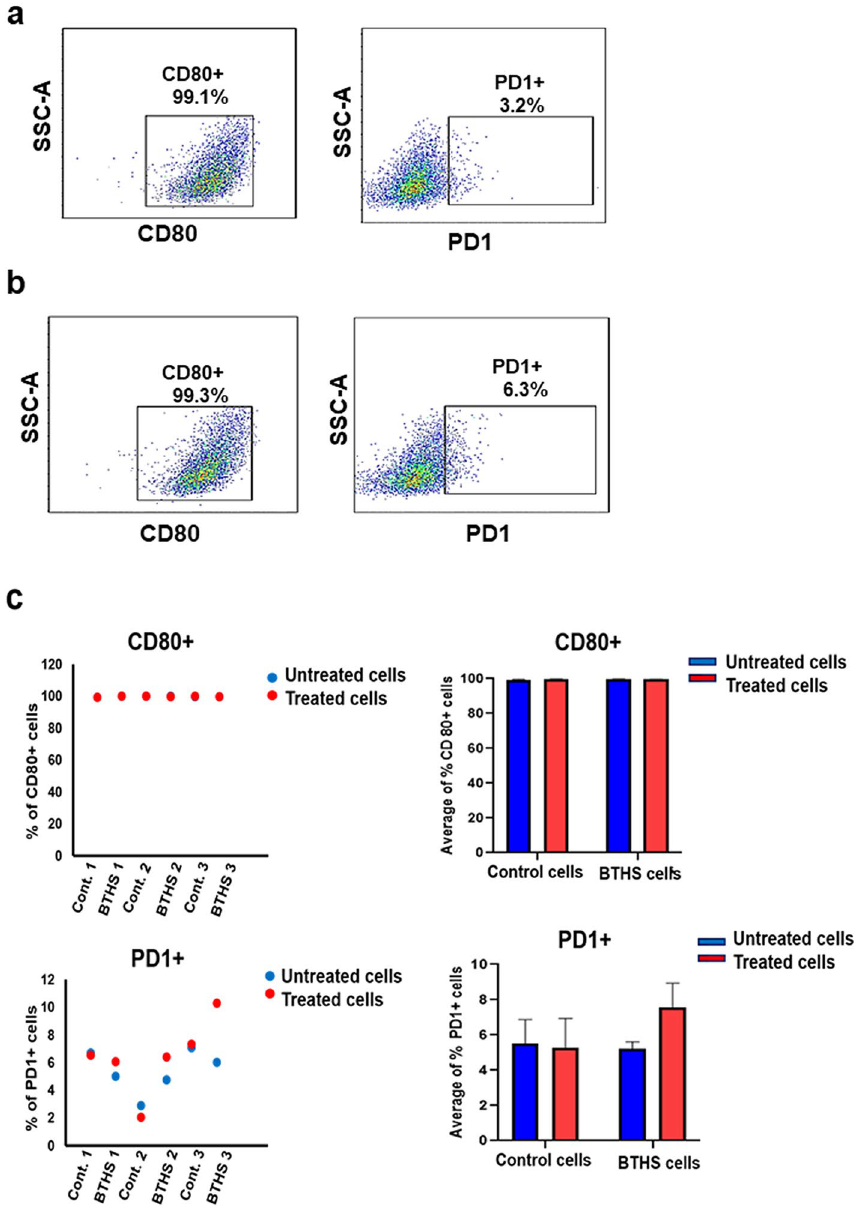
Figure 3. CD80 + and PD1 + surface markers expression in Epstein-Barr virus transformed human age- matched control and BTHS lymphoblasts after LPS stimulation. The expression of CD80 + and PD1 + surface markers were determined in control and BTHS lymphoblasts after stimulation without or with 10 µg/ml LPS using flow cytometry as described in “Materials and Methods”. ( a ) Representative flow cytometry images of CD80 + and PD1 + surface markers in control cells after LPS stimulation. ( b ) Representative flow cytometry images of CD80 + and PD1 + surface markers in BTHS cells after LPS stimulation. ( c ) Histograms showing percentage of CD80 + and PD1 + surface markers expression in LPS treated control and BTHS cells compared to untreated control and BTHS cells. N =